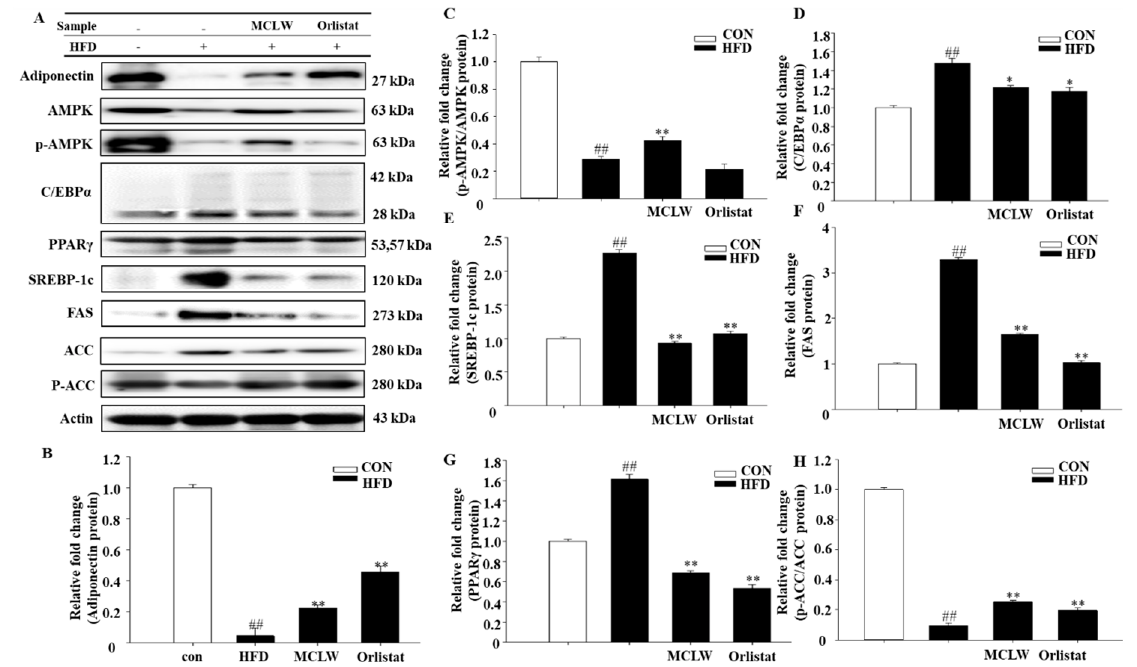
Figure 8. Western blot ( A ). Adiponectin ( B ), p-AMPK/AMPK ( C ), C/EBP α ( D ), PPAR- γ ( E ), SREBP-1c ( F ), FAS ( G ), and p-ACC/ACC ( H ) protein expression levels, normalized relative protein expression data to actin expression levels. Data are mean ± SEM. n = 3, Student’s unpaired t -test with Benjamini–Hochberg correction, ## p < 0.01 vs. the CON. * p < 0.05, ** p < 0.01 vs. the HFD.